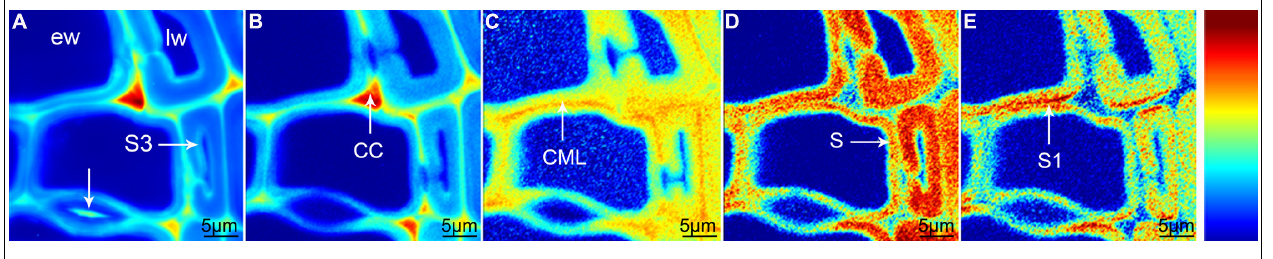
composition by band height ratio of 1598/1657 cm − 1 (C), cellulose content by band integration from 401 to 331 cm − 1 (D), change in orientation of cellulose microfibrils by integration from 1106 to 1083 cm − 1